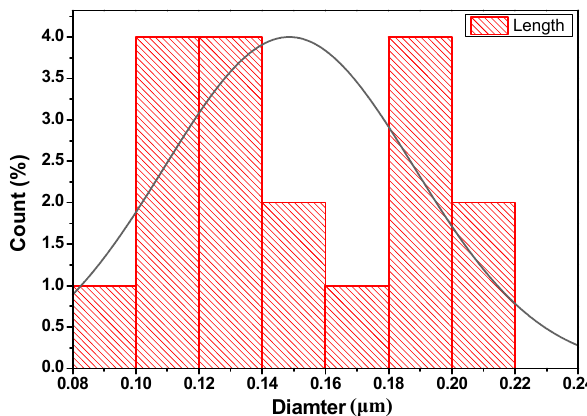
Figure 3. Particle diameter distribution in NiO catalyst.